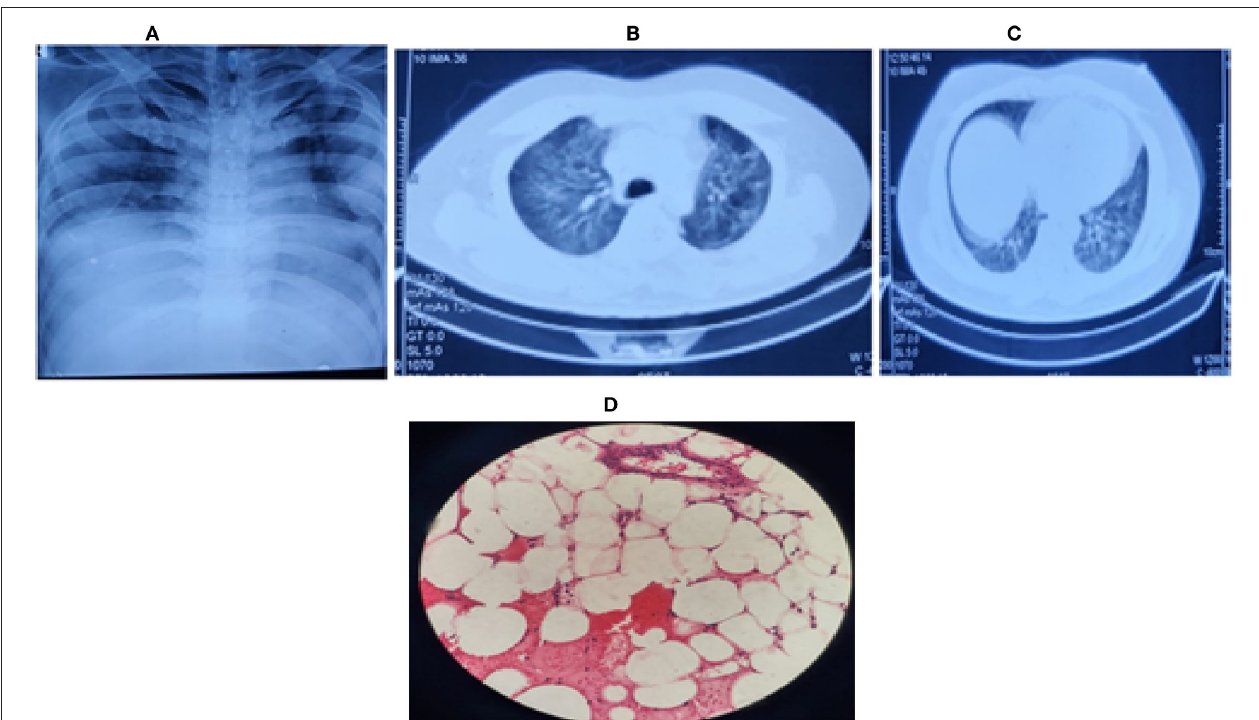
FIGURE 1 | (A) Chest radiograph (bedside) on first day, showing bilateral middle zone haziness, (B) Contrast enhanced CT (CECT) chest on second day showing bilateral ground-glass opacities in lung parenchyma with (C) left upper lobe consolidation and air bronchogram. (D) Bone marrow biopsy showing hypocellular marrow (overall cellularity < 15%), lacunar spaces extensively replaced by fat cells; the residual cellularity mostly included lymphocytes, plasma cells, mast cells, and macrophages with only a few hematopoietic